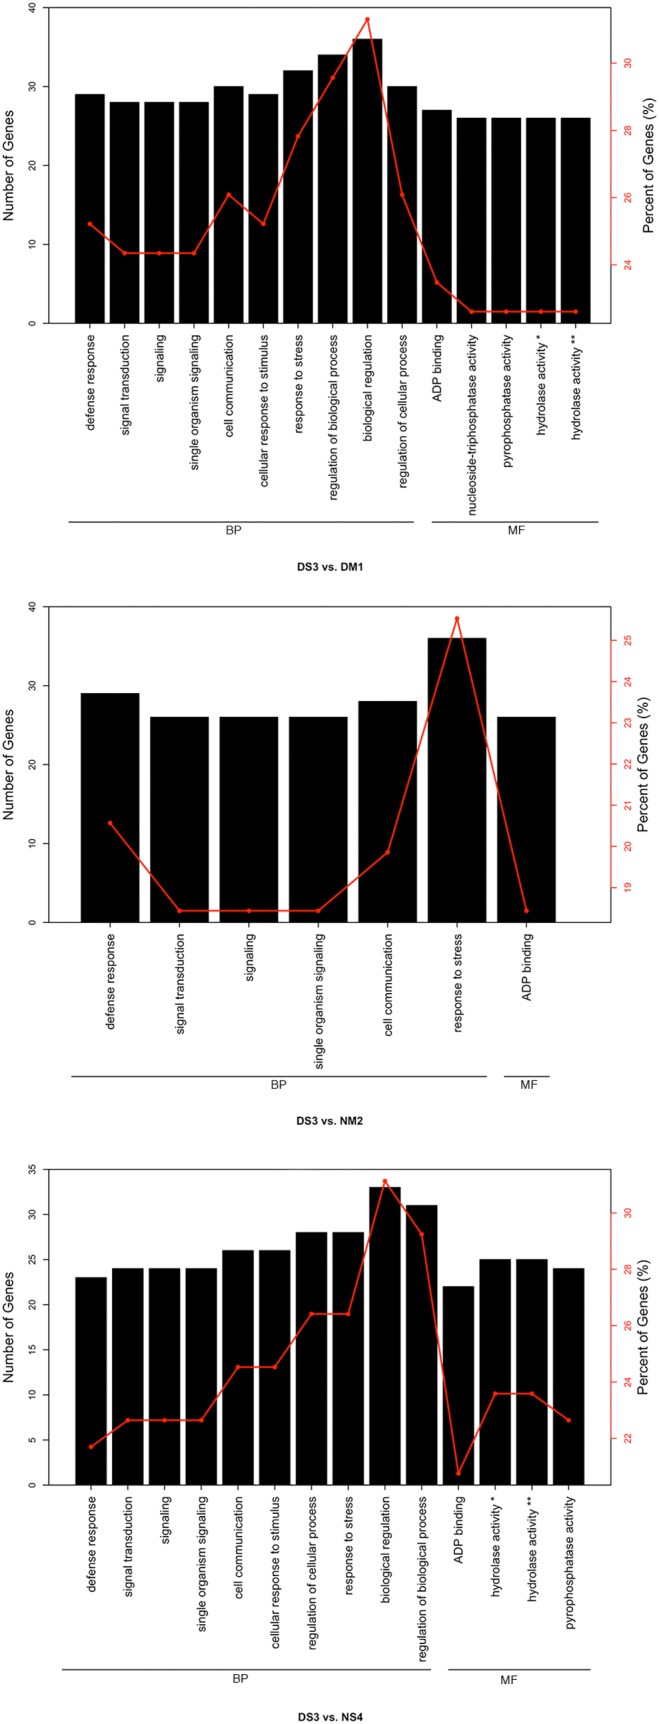
GO functional enrichment of genes differentially expressed in alfalfa.Gene classification based on gene ontology (GO) for the differential expression miRNA target genes in DS3 vs DM1, DS3 vs NM2 DS3, and DS3 vs NS4. The number of genes in GO terms was analyzed using GO Slim Assignment. Biological processes and molecular function were used for GO analysis. (Hydrolase activity* = hydrolase activity, acting on acid anhydrides, in phosphorus-containing anhydrides;hydrolase activity** = hydrolase activity, acting on acid anhydrides; BP, Biological Process; MF, Molecular Function).